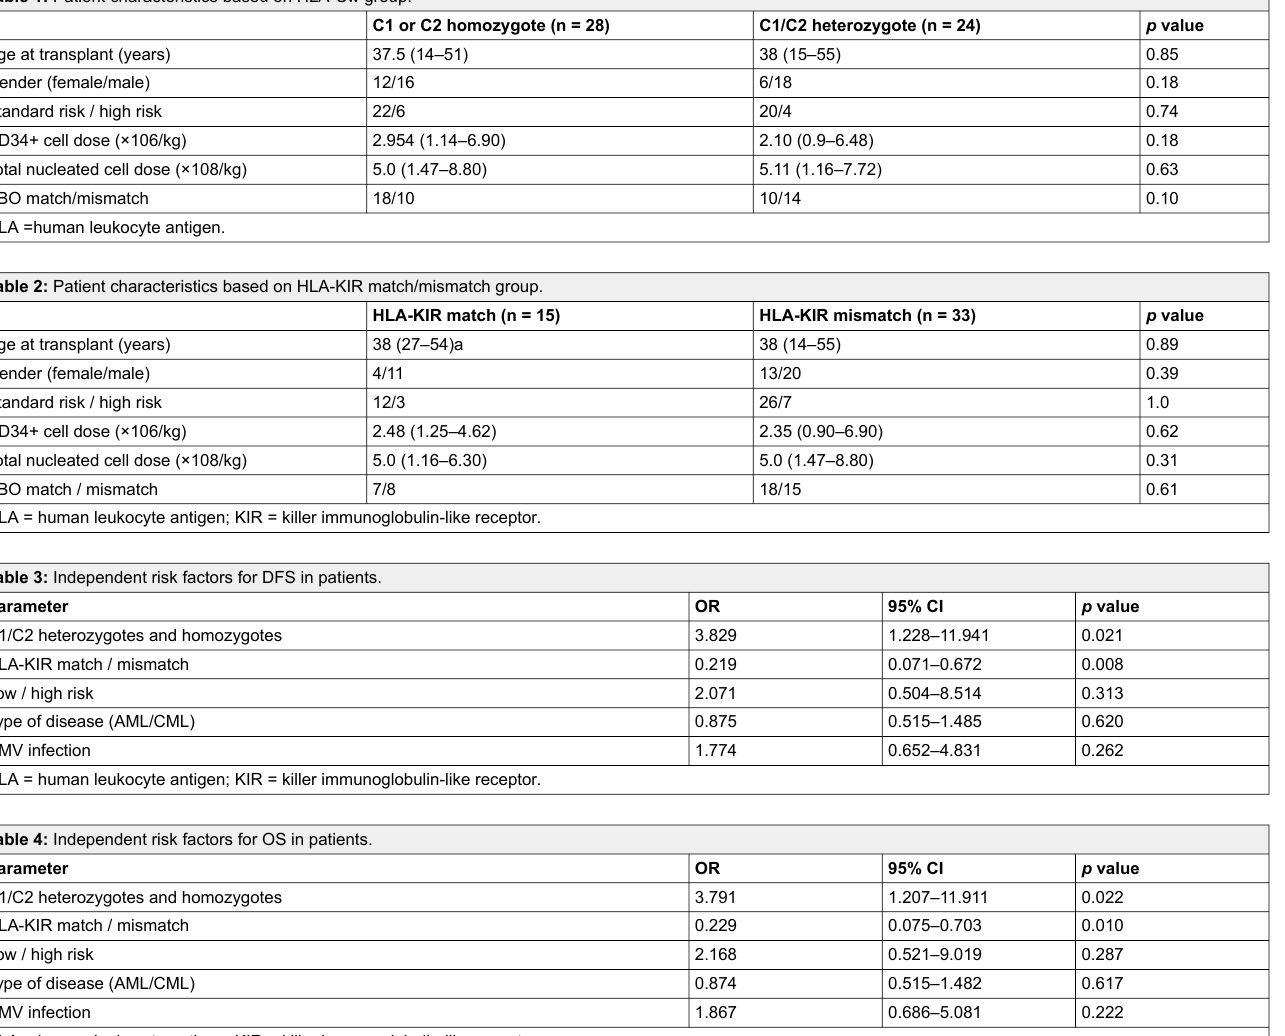
Table 1: Patient characteristics based on HLA-Cw group.